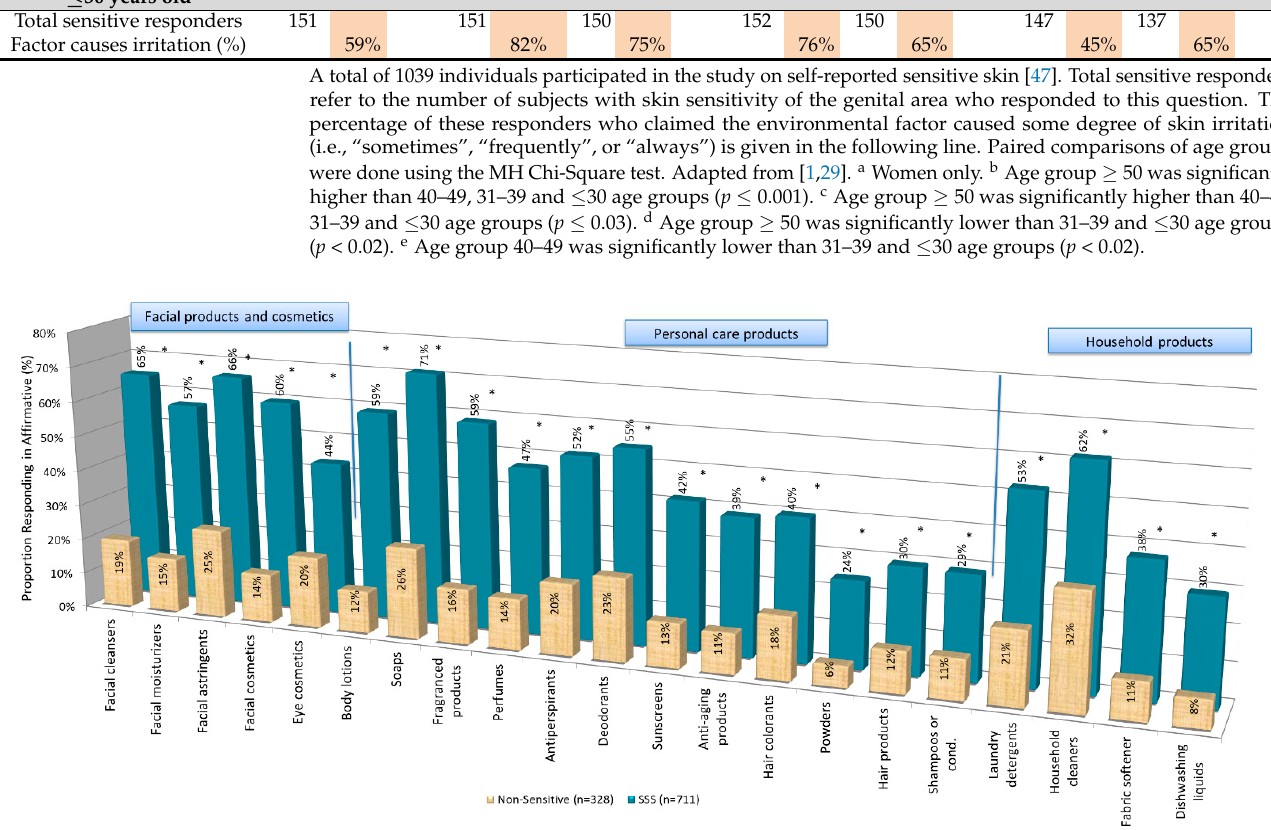
Figure 3. Product Categories Reported to Trigger SSS Symptoms. Responders in the Cincinnati study were asked if a variety of categories of cosmetics, personal care and household products had ever caused adverse reactions to their skin [35,36]. For all product categories the proportion of SSS individuals who responded positively was significantly higher than the number of non-SSS individuals who responded positively. (* = p < 0.00001).